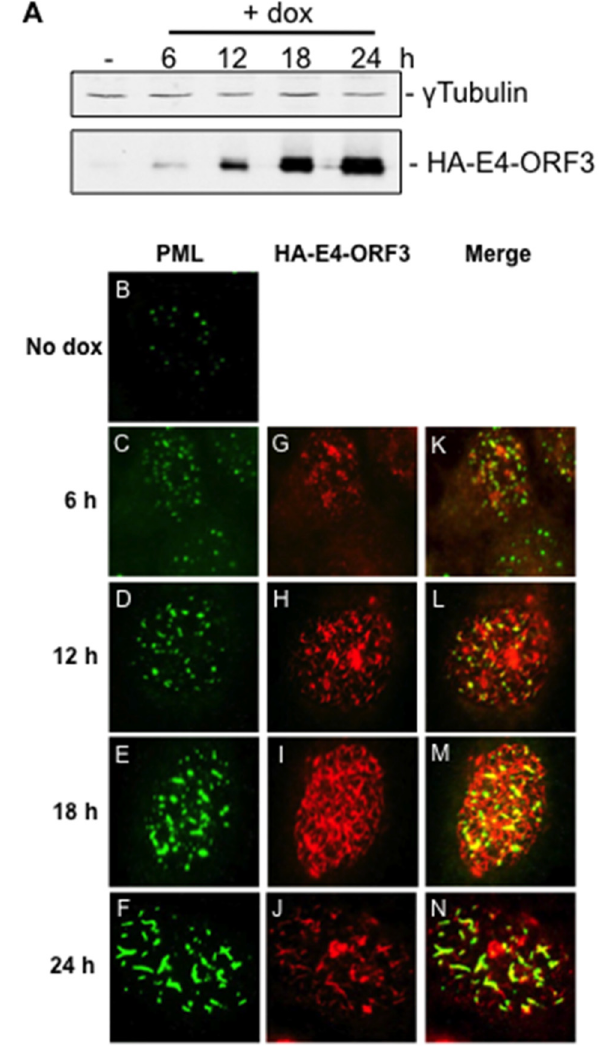
Figure 1. Doxycycline-treated Tet-E4-ORF3 cells produce HA-E4-ORF3 capable